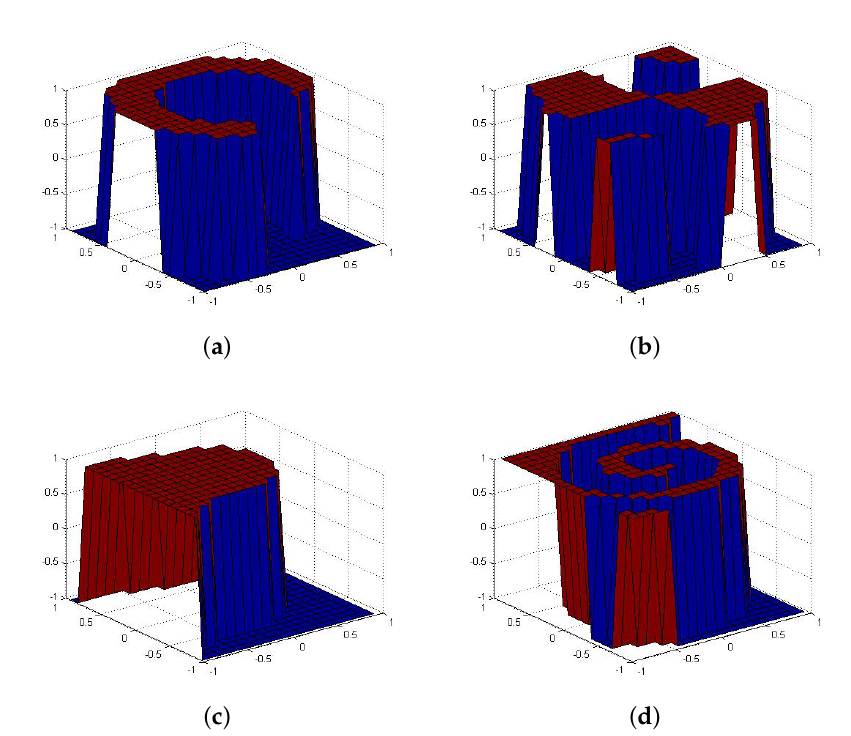
Figure 4. ( a ) Data set Cluster. ( b ) Data set Corners. ( c ) Data set Half Kernel ( d ) Data set Spiral.